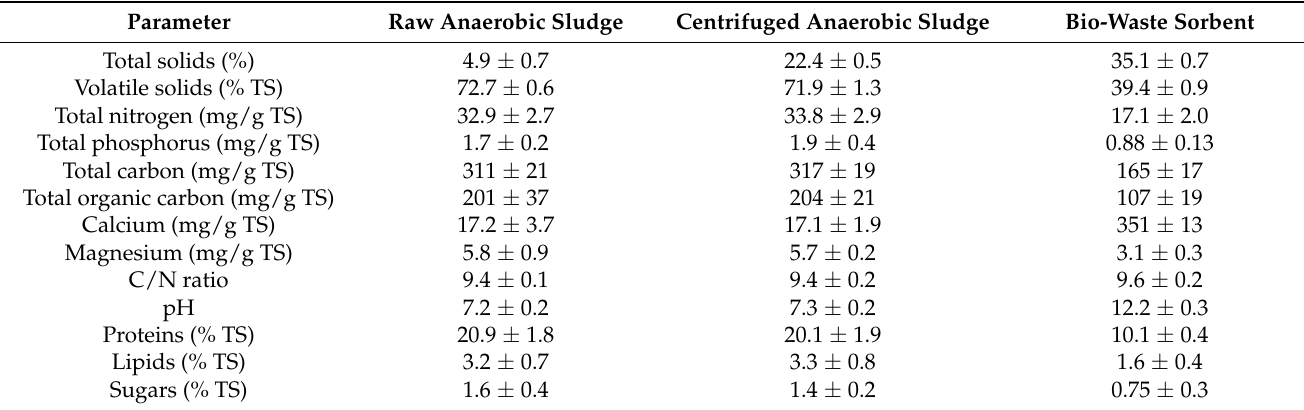
Table 1. Characteristics of the raw anaerobic sludge, centrifuged anaerobic sludge, and bio-waste sorbent.